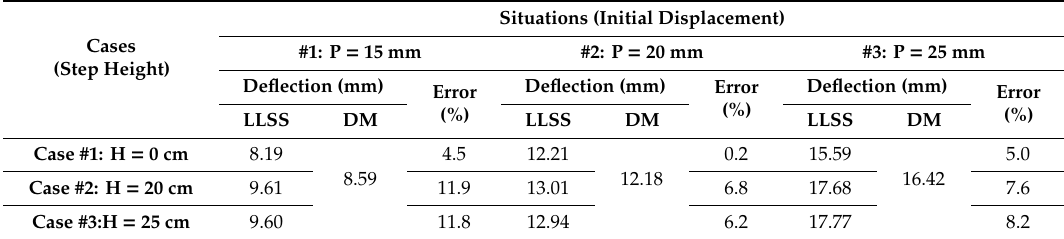
Table 5. Measurement point #1: values of the first valley of the time history data of all situations.